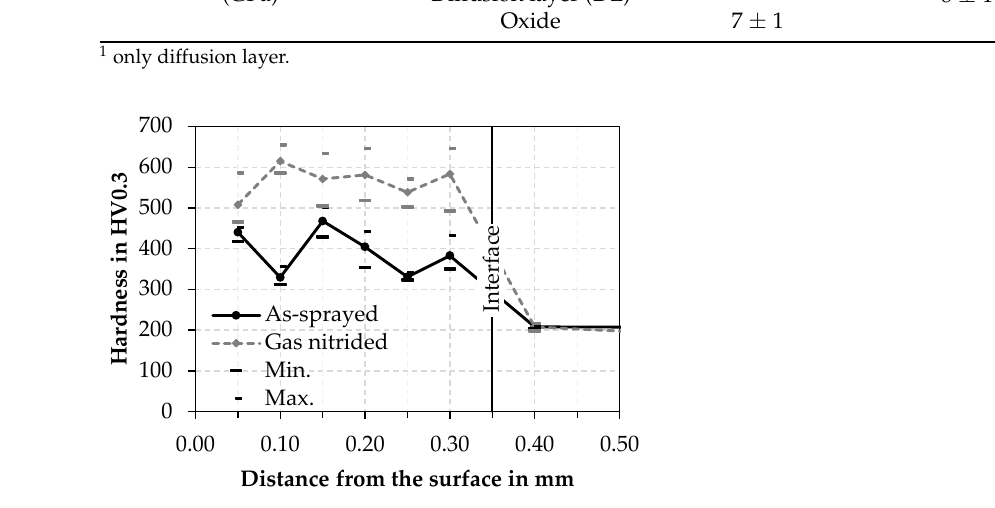
Figure 3. Hardness depth profiles of the arc sprayed 17Cr steel coating in the as-sprayed and gas nitrided state.